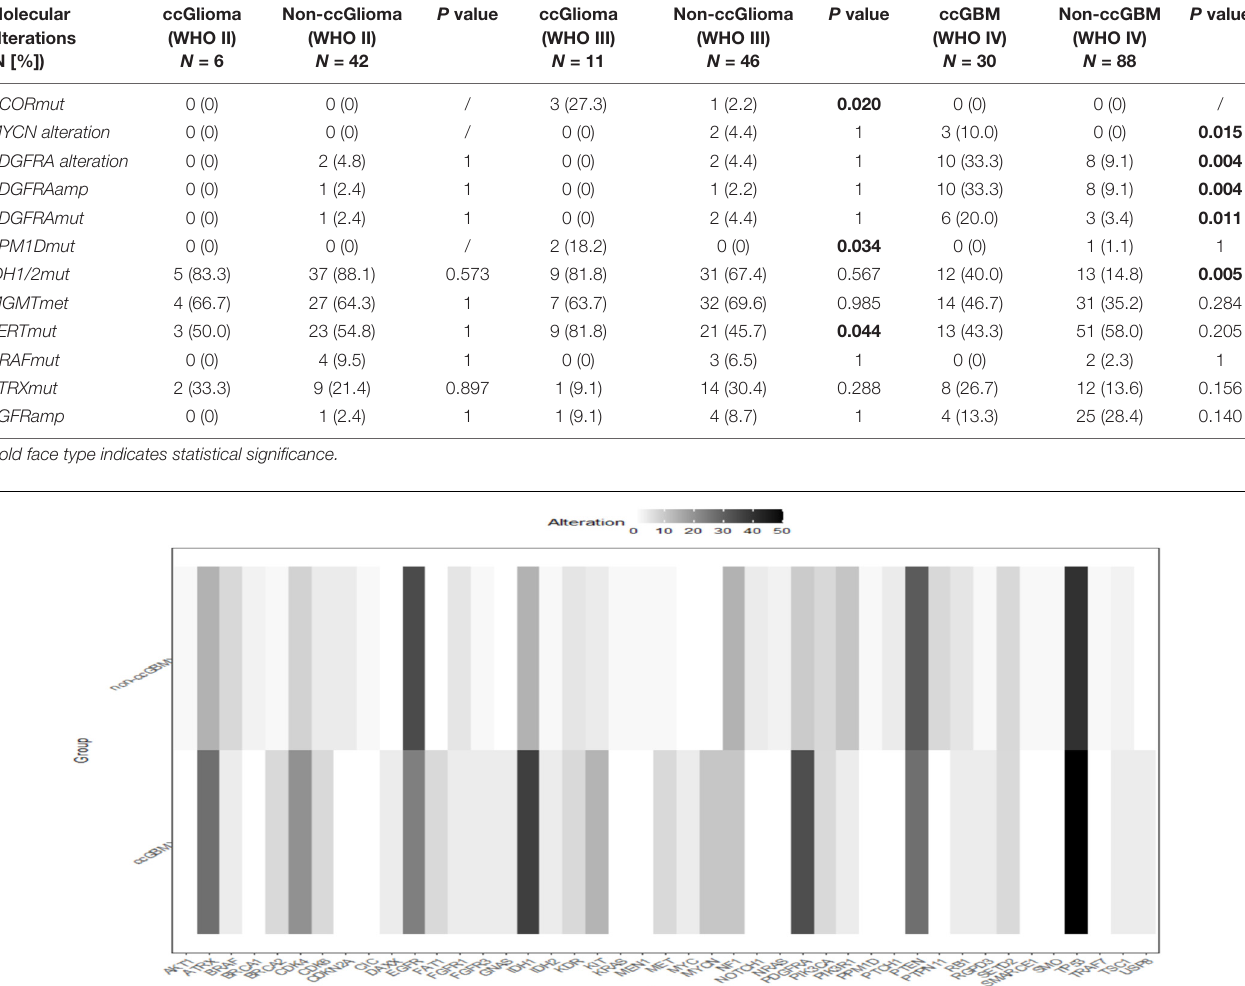
PDGFRA-w, non-amp group. The ccGBM with PDGFRAamp- mut group also had a lower median EOR value than the non-ccGBM with PDGFRA-w, non-amp group (95.97 vs. 100%, P = 0.045) ( Table 3